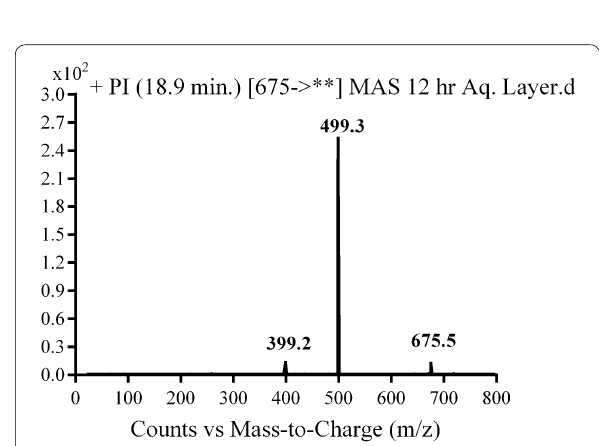
Fig. 16 PI mass spectrum of parent ion (MG1) at m/z